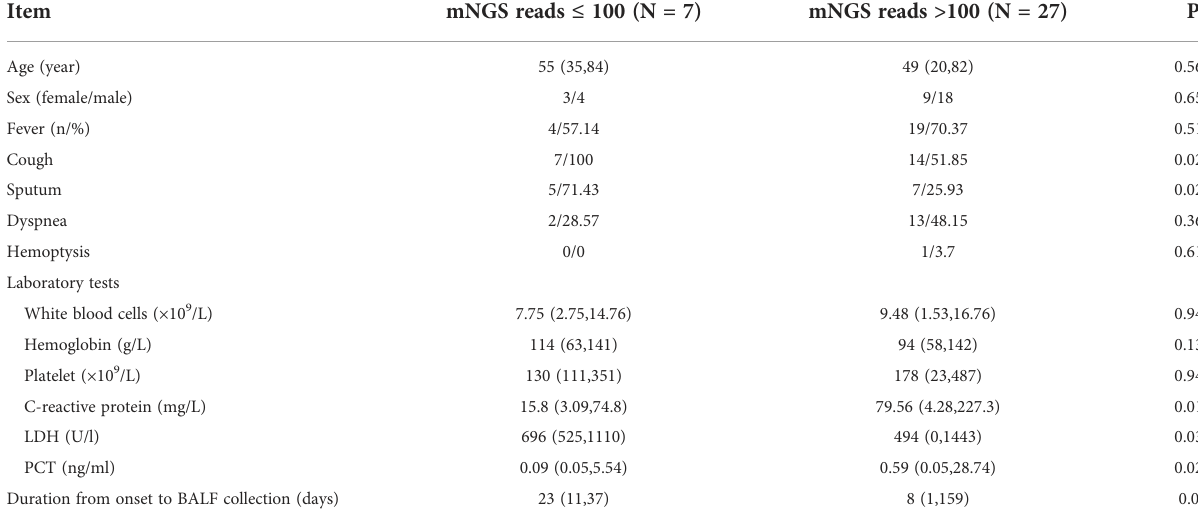
TABLE 2 Comparison of different P. jirovecii reads abundance